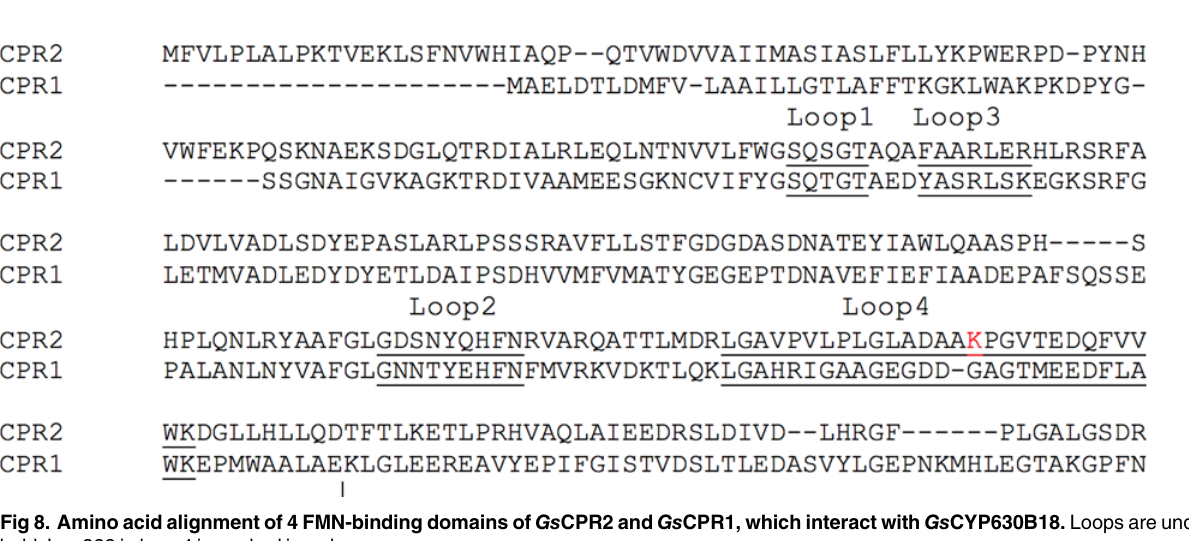
PLOS ONE | DOI:10.1371/journal.pone.0120119 March 20,